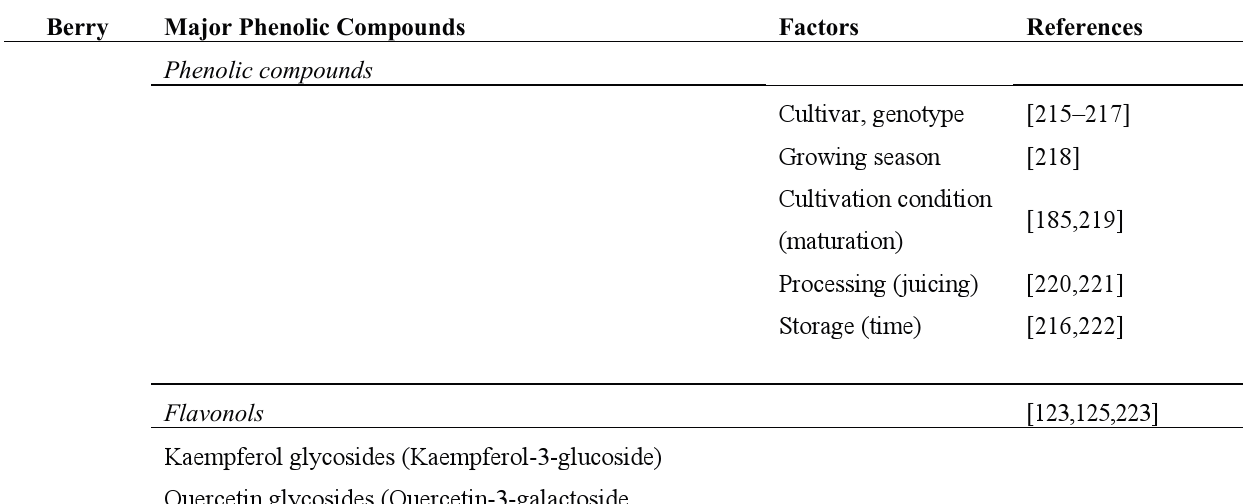
Table 5. Phenolic composition and factors influencing the composition of